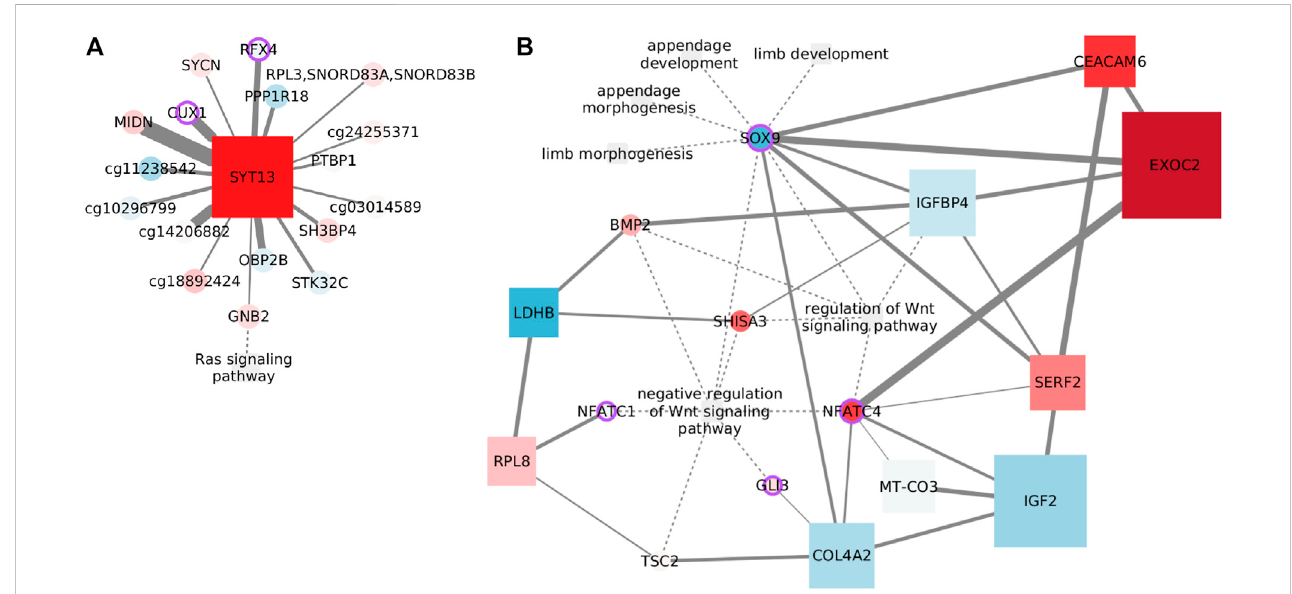
FIGURE 7 Example networks for the luminal subtypes. (A) Features connected with the Ras signaling pathway in luminal A data. Node size indicates degree. (B) Features connected with Wnt signaling in the luminal B subtype. Node size re fl ects betweenness